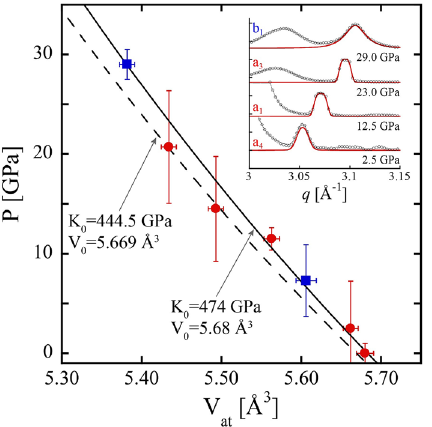
Figure 2. Atomic volume, obtained from the position of the (111) diffraction peak, of diamond products as a function of pressure. Red circles correspond to ‘a’ series measurements (decomposition at 11.5 Gpa) and blue squares to ‘b’ series measurements (decomposition at 29.0 GPa) shown in Fig. 1. The dashed line is the Vinet EOS for cubic diamond from 19 . The solid line is a Vinet EOS fit to the data shown here. Representative fits (red lines) to the diamond (111) diffraction peaks are shown in the